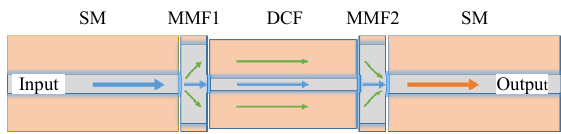
Fig. 1 Schematic of the MMF-DCF-MMF structure.